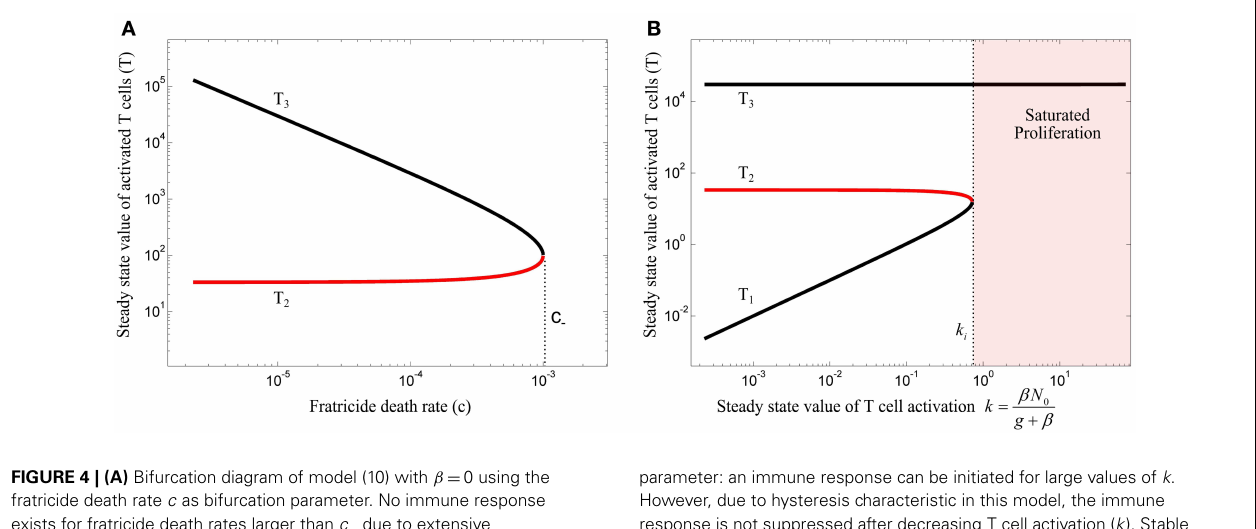
FIGURE 4 | (A) Bifurcation diagram of model (10) with β = 0 using the fratricide death rate c as bifurcation parameter. No immune response exists for fratricide death rates larger than c − due to extensive activation-induced cell death.The trivial equilibrium point is omitted in this figure. (B) Bifurcation diagram of model (10) using k as bifurcation